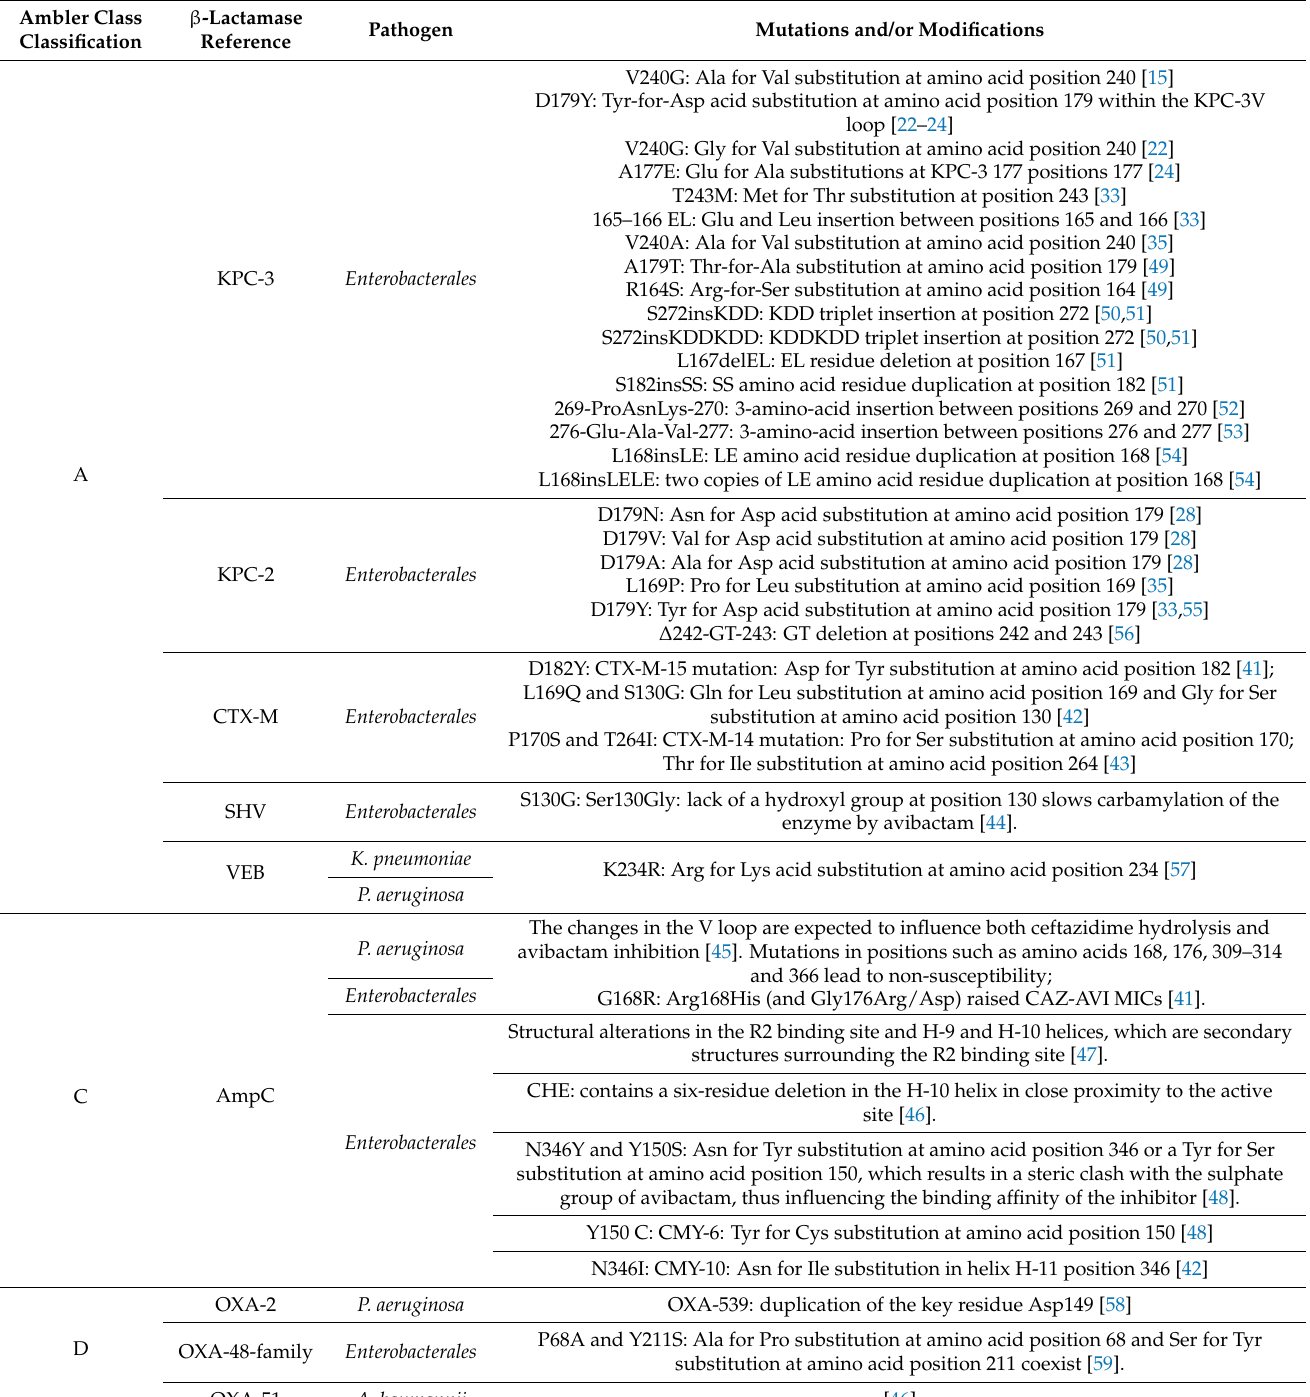
Table 1. Mutations and structural modifications related to the resistance mechanisms for ceftazidime- avibactam (CAZ-AVI) in Gram-negative MDR